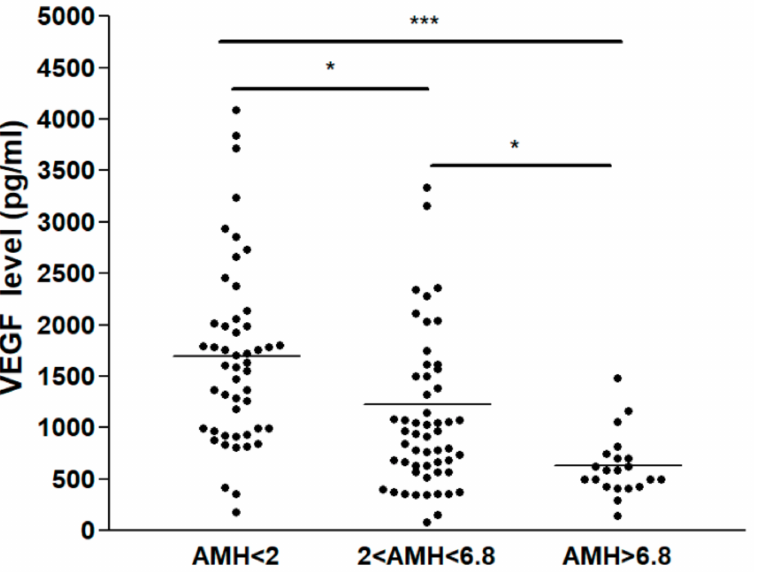
Figure 1. Relationship of VEGF concentration in follicular fluid (FF VEGF concentration) to AMH level. FF VEGF concentration in different AMH groups of IVF patients. Statistical difference: * p < 0.05 and *** p < 0.01 between the AMH